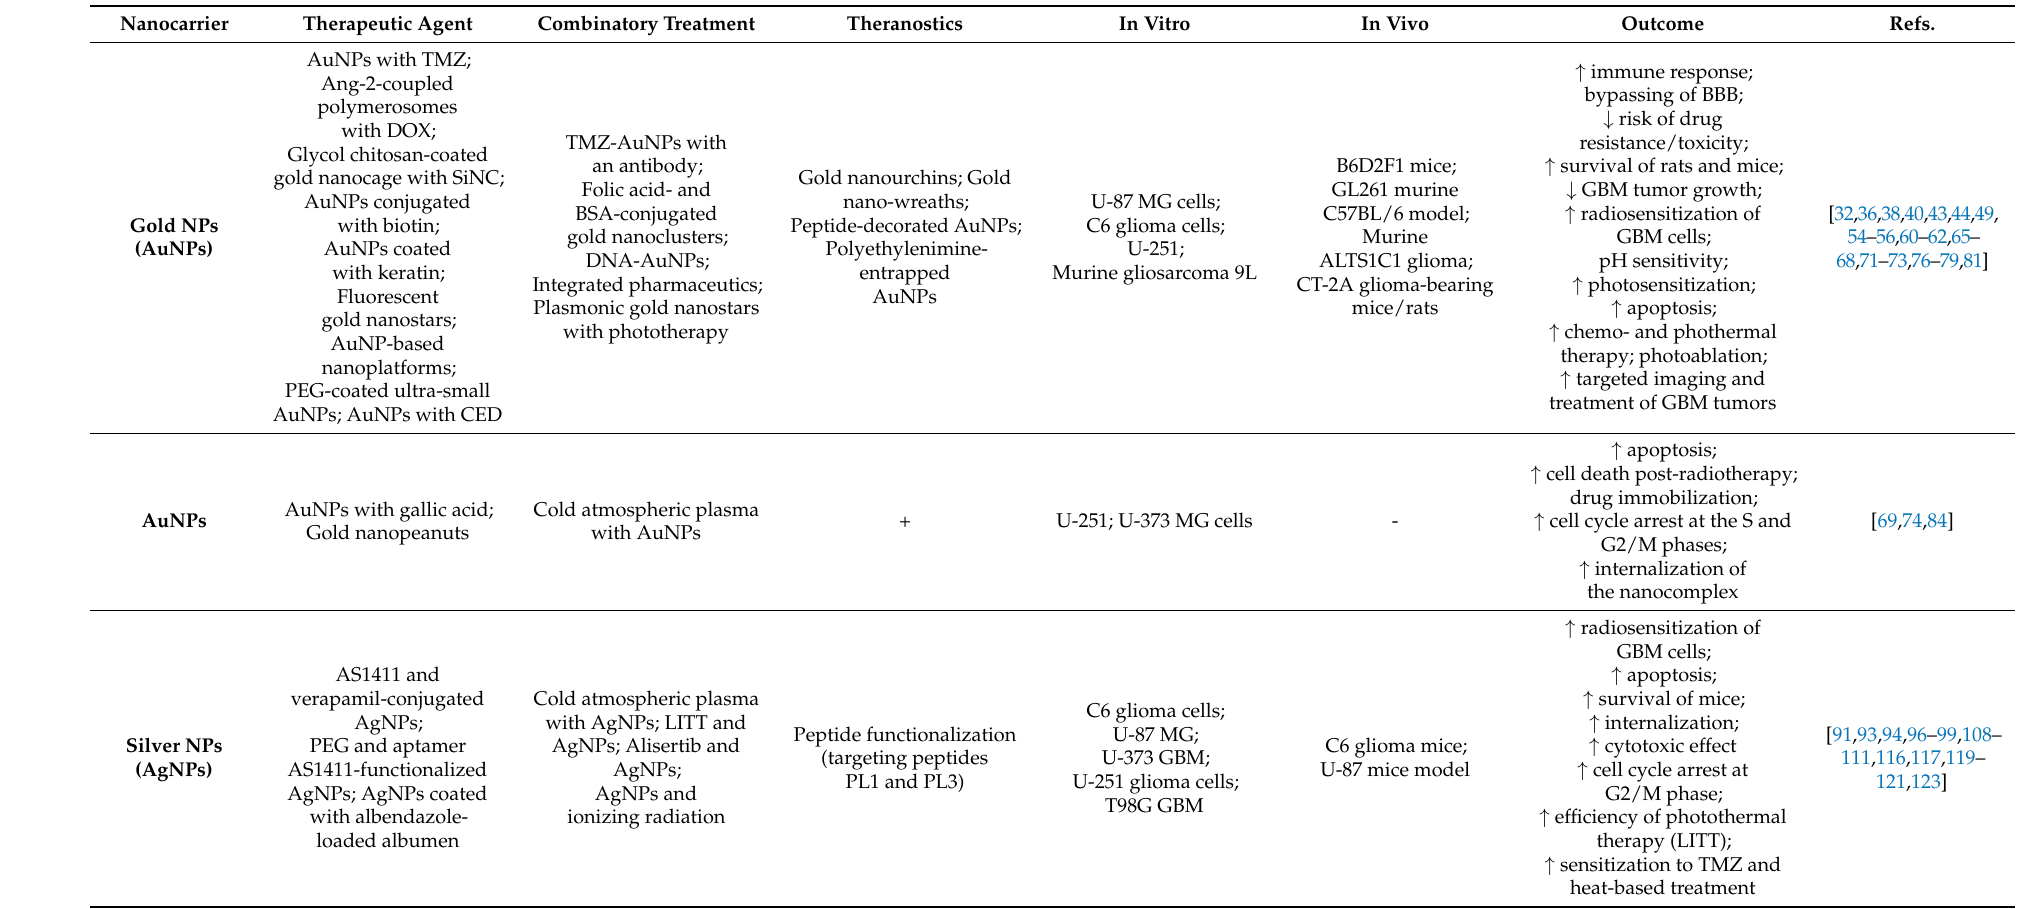
Table 1. Summary of metal-based therapeutic nanoparticles studied for GBM